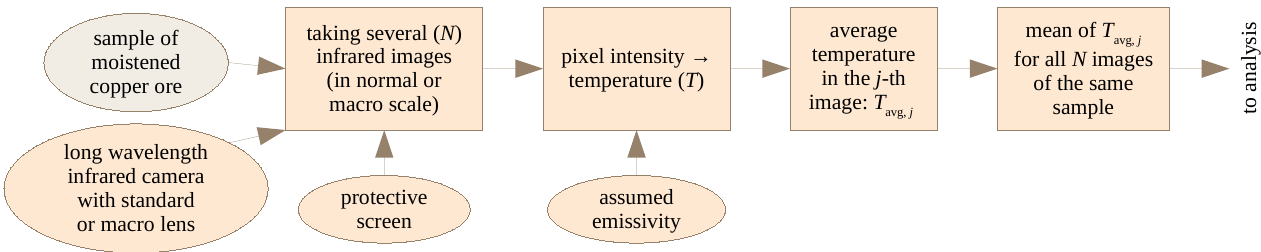
Figure 5. Stages of acquisition and processing of thermovision images.